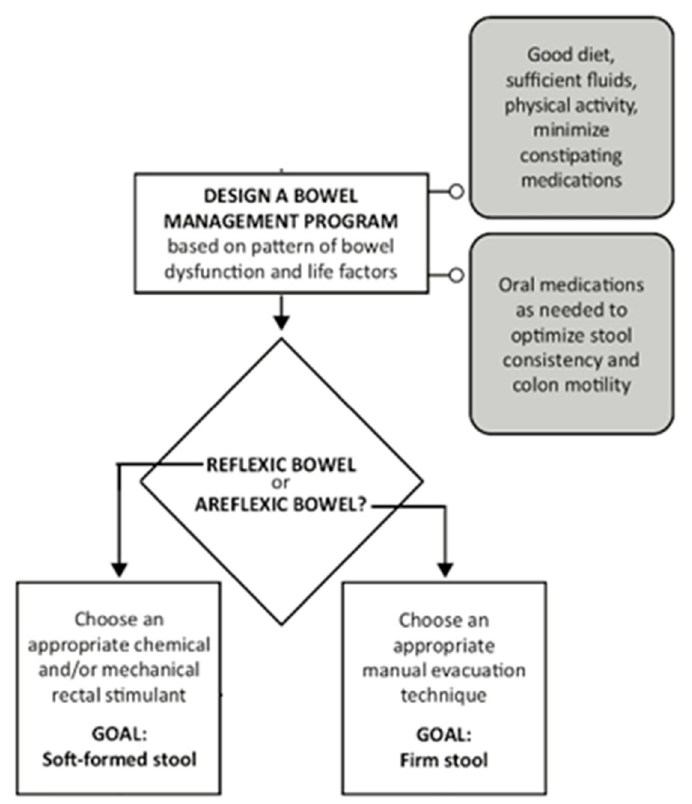
Figure 1. Designing a neurogenic bowel program. Reprinted (a portion of the original algorithm) from “Management of Neurogenic Bowel Dysfunction in Adults after Spinal Cord Injury: Clinical Practical Guidelines for Healthcare Providers (2020), with permission from Paralyzed Veterans of America.